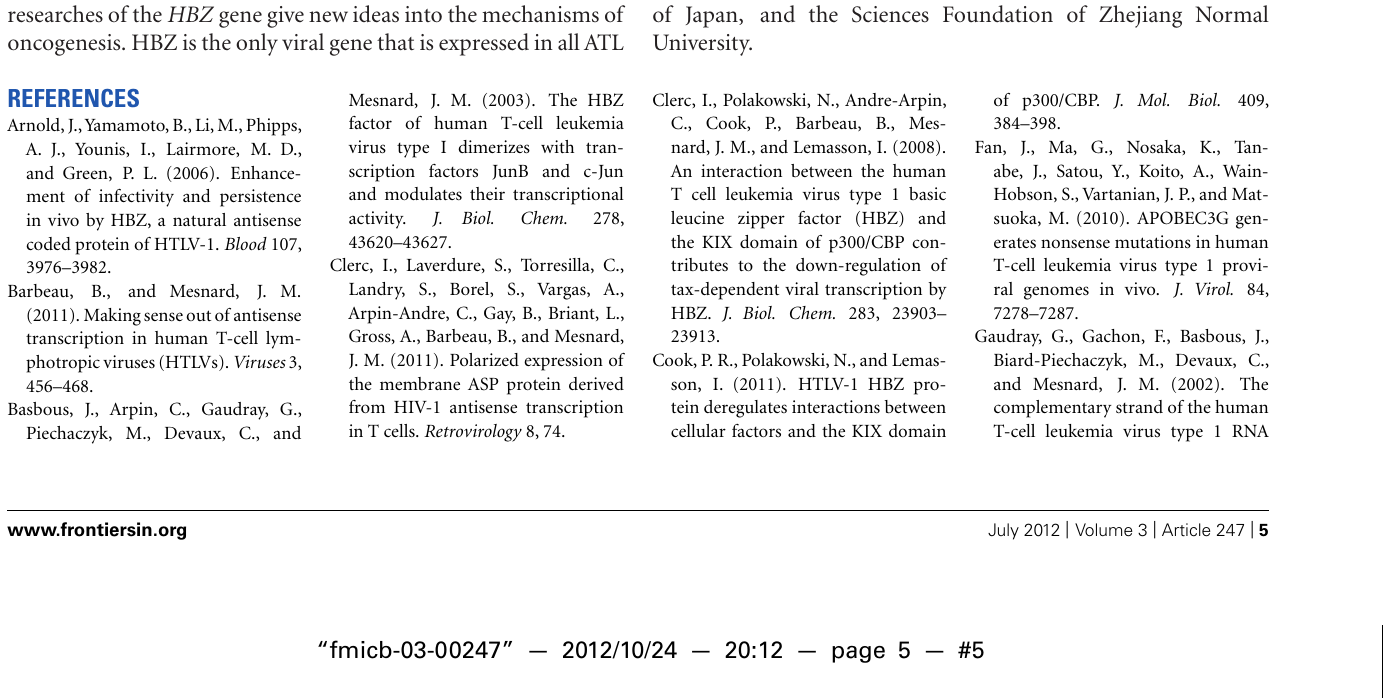
cases. Except the HBZ gene, non-sense mutations of other viral genes are detected before integration of provirus. Importantly, HBZ maintains the cell survival when Tax is silenced. These